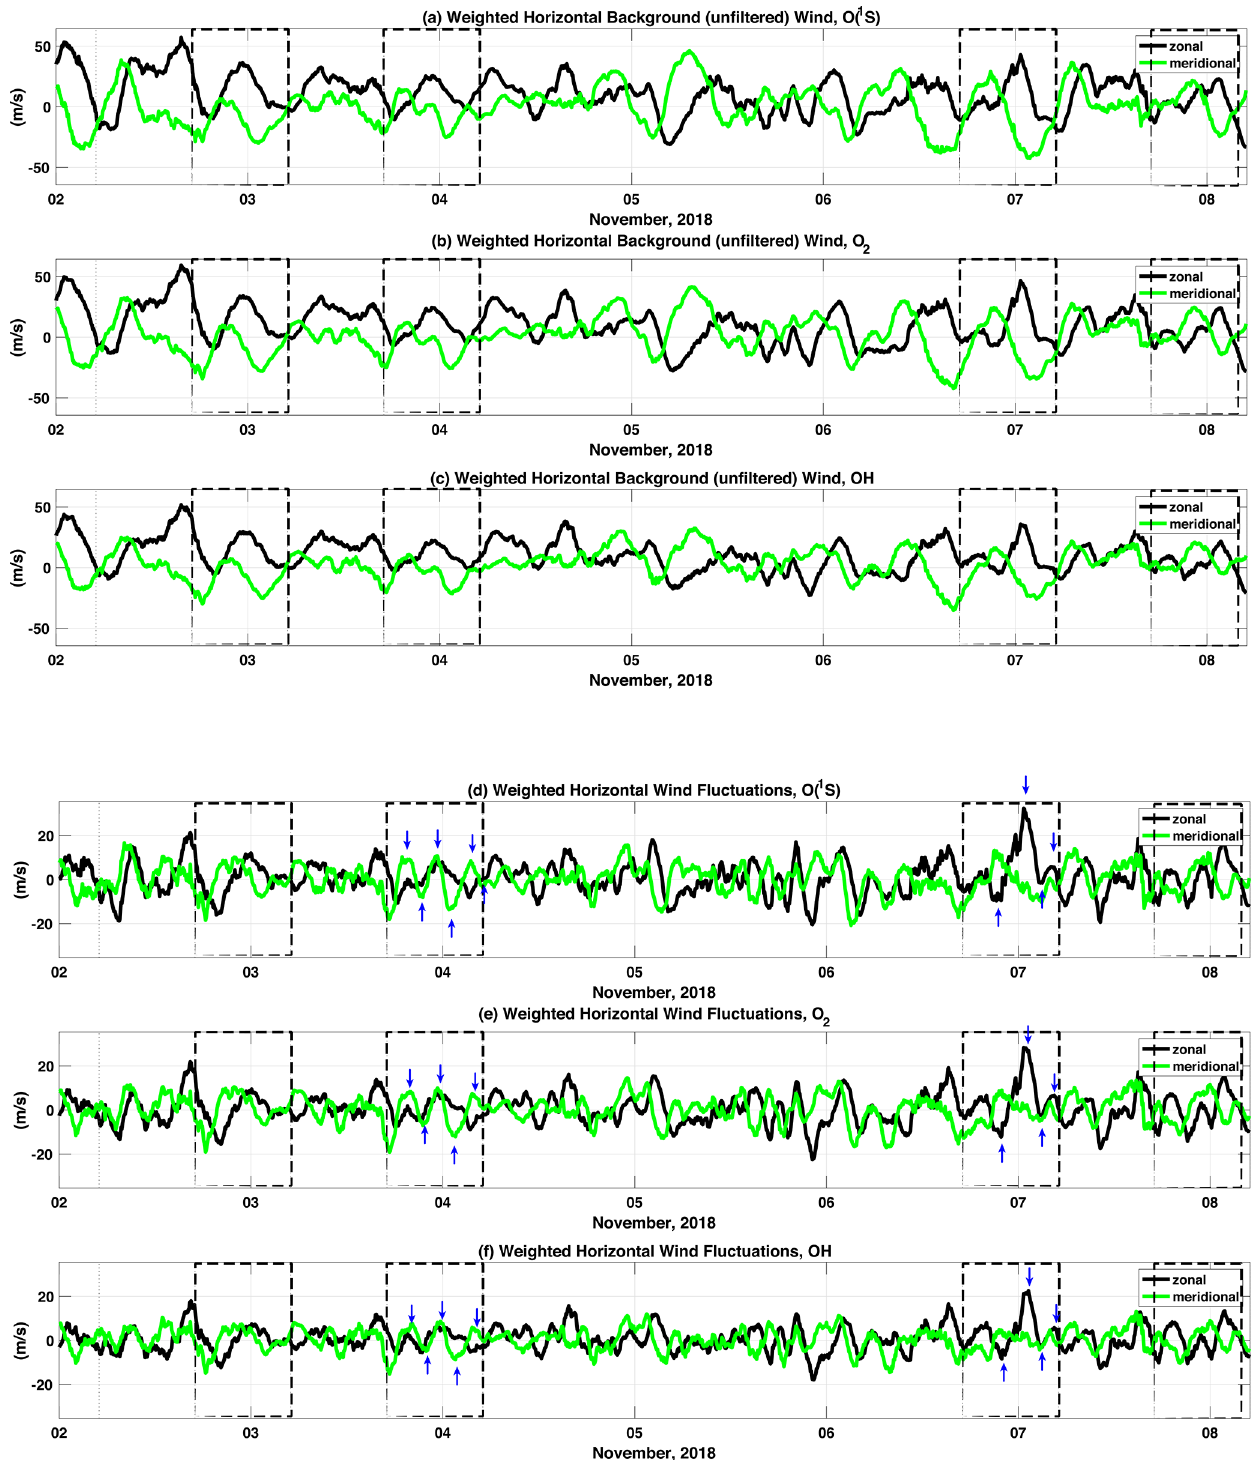
Figure 6. (a) O( 1 S), (b) O 2 , and (c) OH volume emission rate weighted zonal and meridional background (unfiltered) winds. (d) O( 1 S), (e) O 2 , and (f) OH volume emission rate weighted zonal and meridional wind fluctuations. Wind fluctuations were obtained first by averaging the wind over 400km 2 field of view using a 4h temporal, 4km vertical window to obtain winds representing large-scales variations and then subtracting these estimates from the background wind field. The vertical blue arrows indicate coherent wind fluctuations also seen in the airglow brightness. Dashed boxes indicate hours of simultaneous operation of the ASI and MSMR